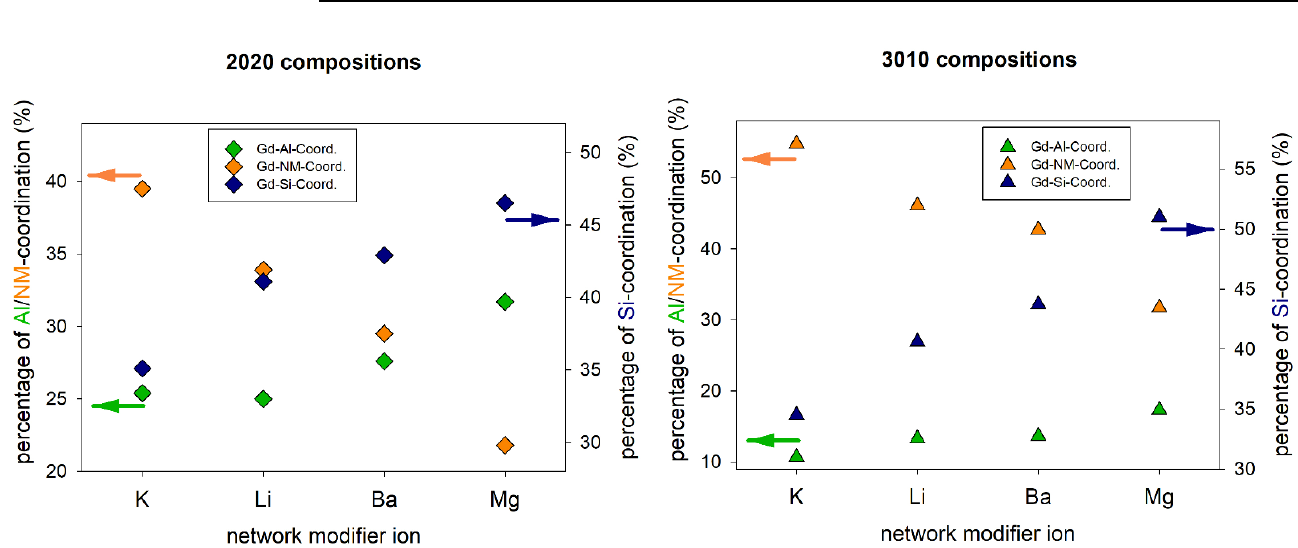
Figure 7. Gd-cation coordination fractions for metaluminous ( left ) and peralkaline ( right ) alkali and alkaline earth aluminosilicate glasses. Values for Ba and Mg-containing glasses are taken from [26].